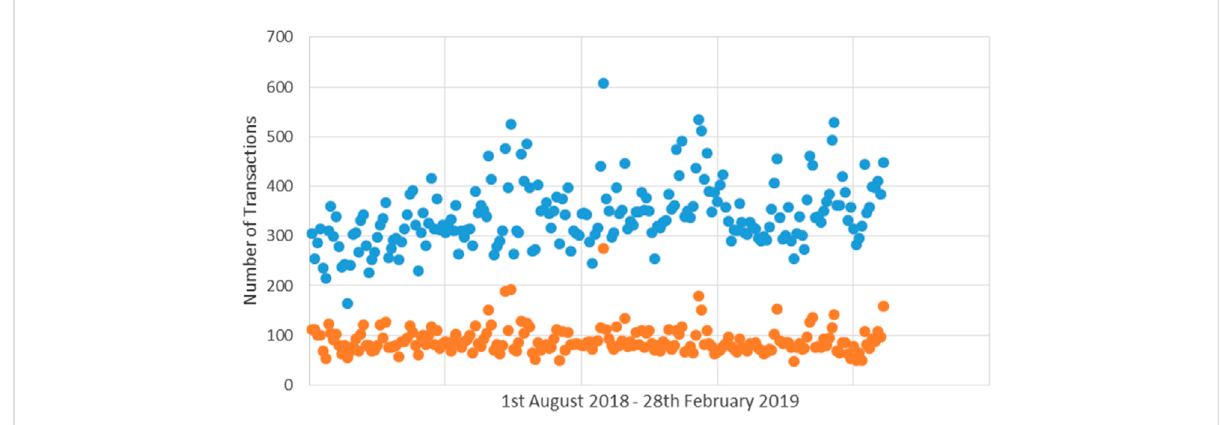
FIGURE 2 The minimum and highest number of transactions between 01/08/2019 and